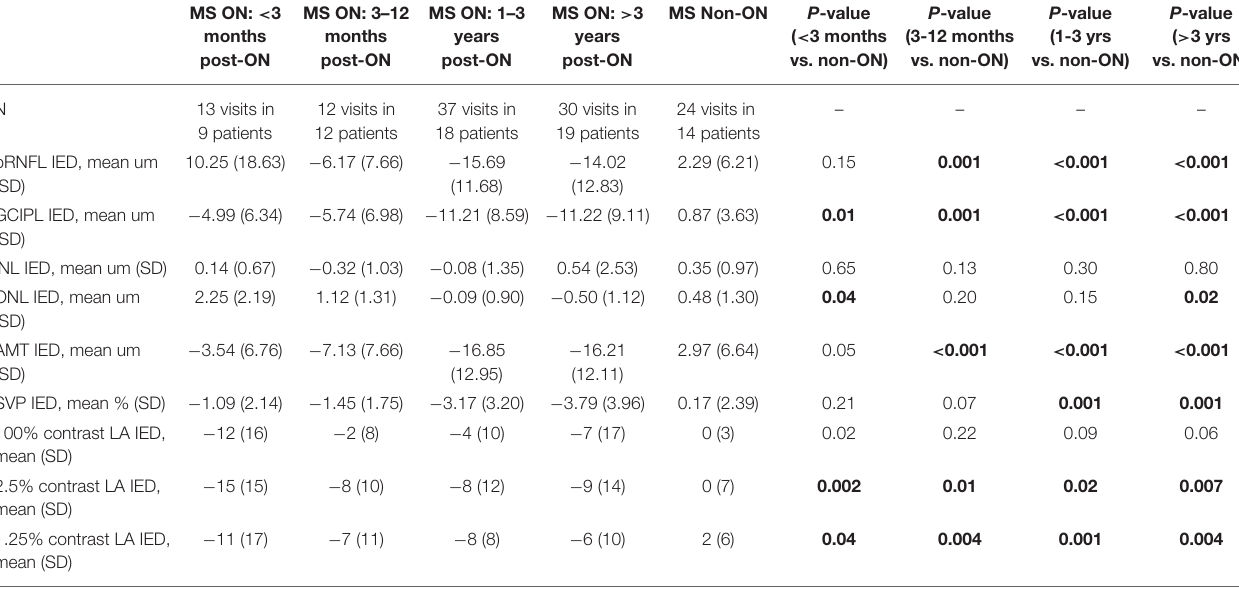
TABLE 4 | Inter-eye differences in OCT, OCTA, and visual function measures, with MS ON patients stratified by time from ON. MS ON: < 3 months